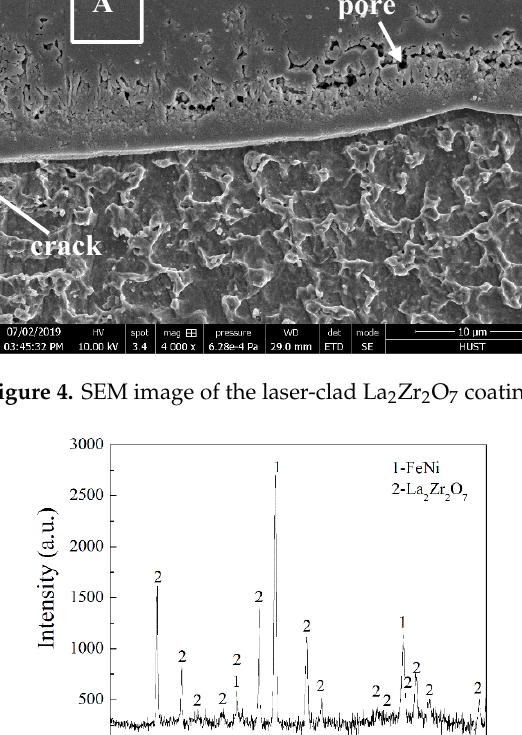
Figure 5. XRD patterns of the laser-clad coating.